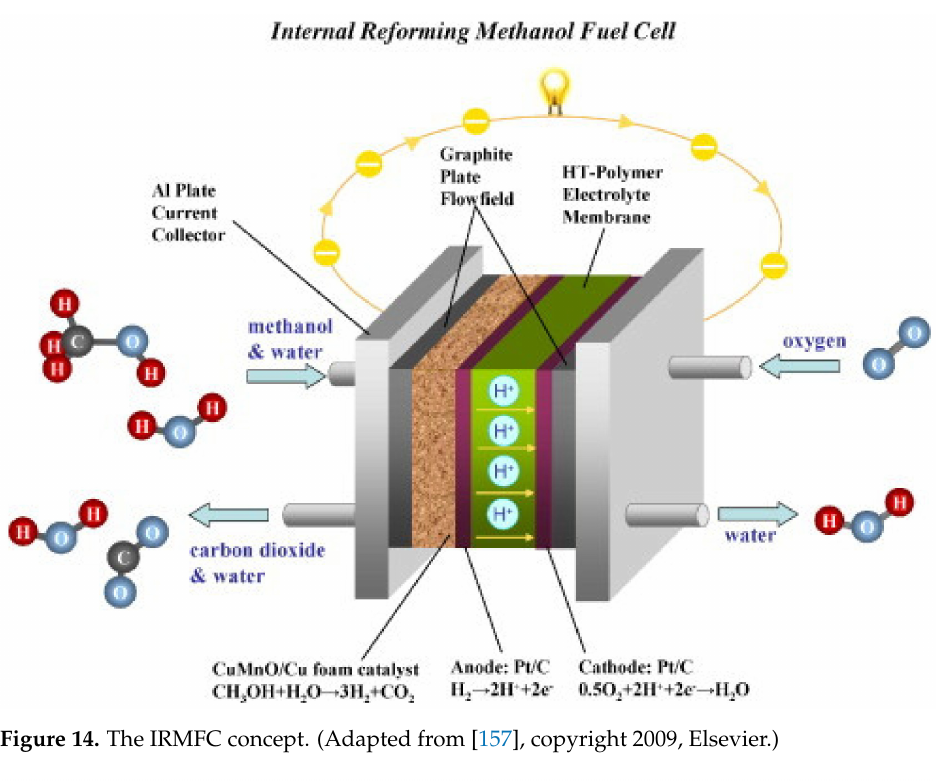
Figure 14. The IRMFC concept. (Adapted from [157], copyright 2009, Elsevier.)